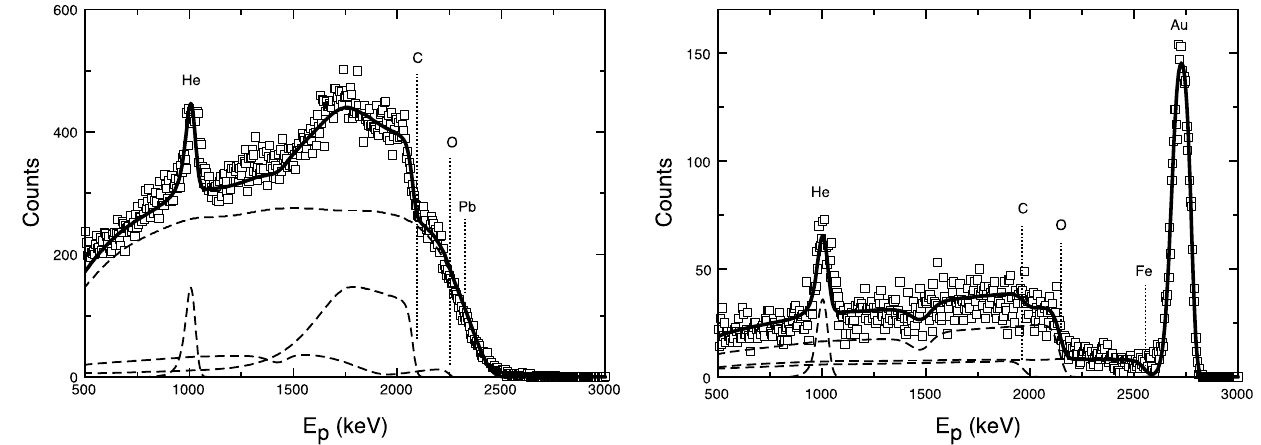
Figure 5. Experimental (open squares) and simulated (full line) RBS spectra obtained with 3 MeV protons. On the left, lead-white paint layer covered with about 15 μ m thick varnish. On the right, 525 nm thick gold leaf laid on wood by a bole clay. The partial spectra of the detected elements (C, O, Fe, Pb, and Au), and the contribution of He from the helium flowing are shown as dashed lines.